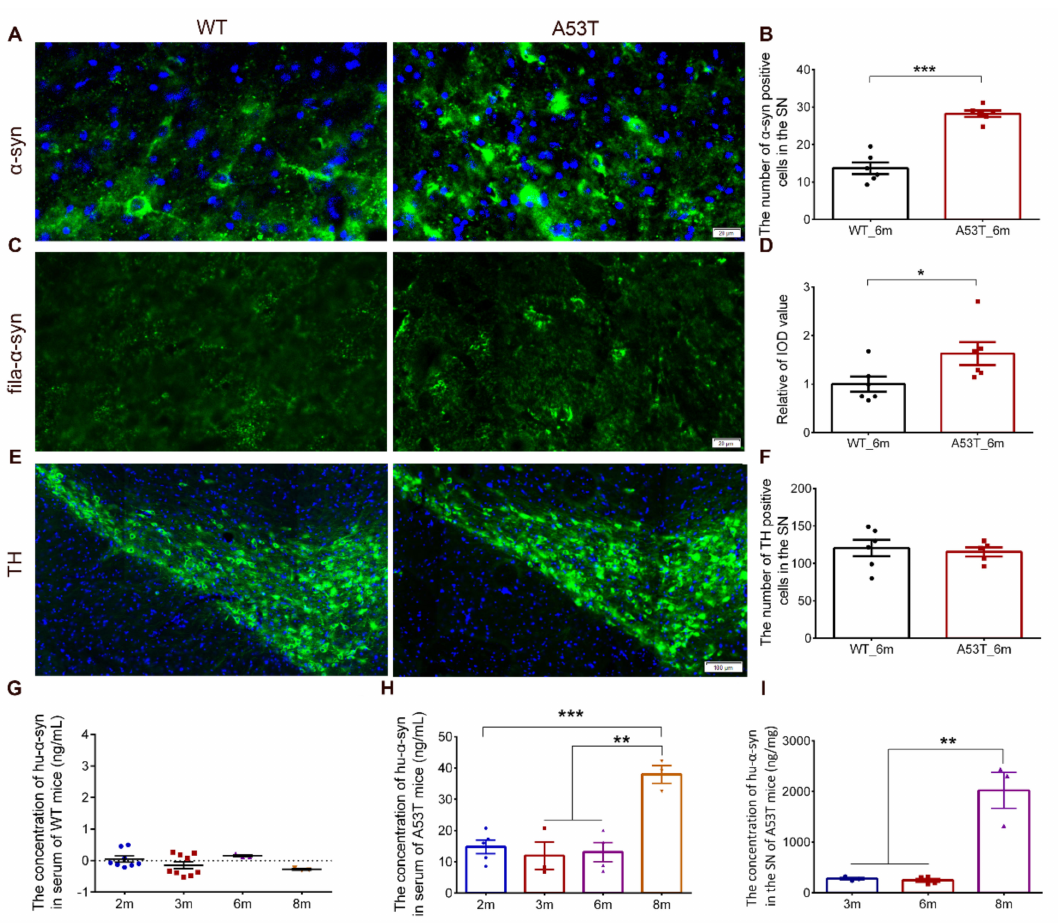
Figure 2. The pathologic changes in α -synuclein of A53T mice. ( A , B ) The number of α -synuclein positive cells (green) in the SN of A53T mice was up-regulated compared with the WT mice. ( n = 6, *** p < 0.001, nucleus were labeled with blue DAPI, bar = 20 µ m). ( C , D ) The integrated optical density (IOD) of α -synuclein filament (fila- α -syn, green) in the SN of A53T mice was up-regulated significantly compared with the WT mice. ( n = 6, * p < 0.05, bar = 20 µ m). ( E , F ) No changes was found in the number of TH positive cells (green) in the SN. ( n = 6, 5, nucleus were labeled with blue DAPI, bar = 100 µ m). ( G ) No Hu- α -syn was detected in serum of WT mice at all time points. ( H , I ) The concentration of Hu- α -syn in the serum and SN of A53T mice was stable before 6 months and increased sharply in 8 months A53T mice. ( n ≥ 3, ** p < 0.01, *** p < 0.001). (The specific levels of each sample in different groups were shown as “ • ”, “ (cid:110) ”, “ (cid:78) ”, and ” (cid:72) ”). In the parabiosis group, homologous WT mice were paired with 2-month-old A53T mice (WT–A53T), whereas in the sham-operated group, homologous WT–WT or